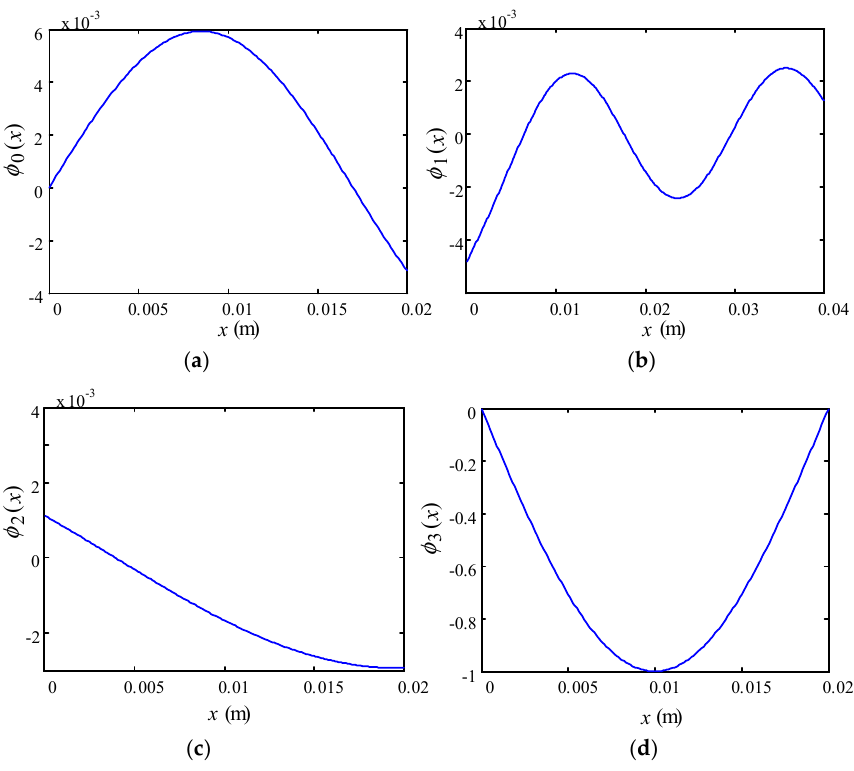
intermediate shaft DE .